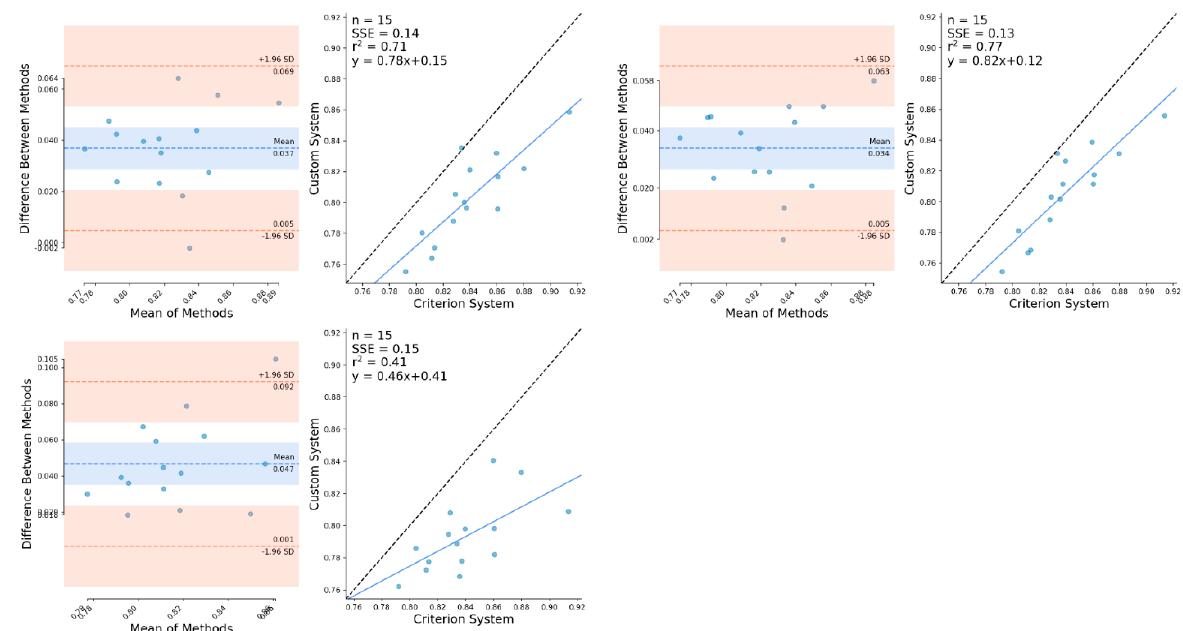
Figure A8. Bland-Altman and linear regression plots demonstrating the differences between OpenPose unfiltered (top-left), low-pass filtered (top-right) and Kalman smoothed (lower-left) CoM vertical position against marker-based CoM vertical position during pushing.